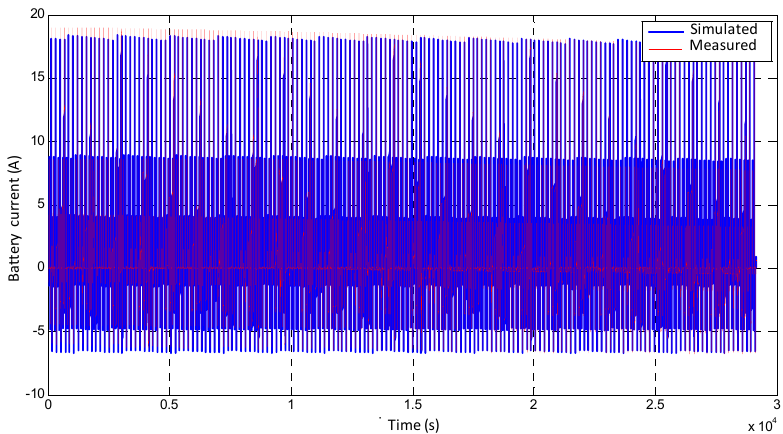
Figure 32. Experimentally measured and simulated battery current along the 8 h working day.